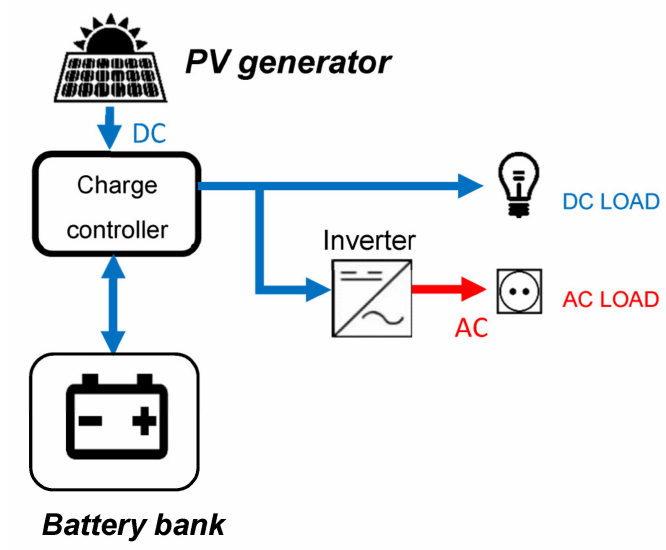
Figure 1. Direct current (DC) coupled standalone photovoltaic (PV)